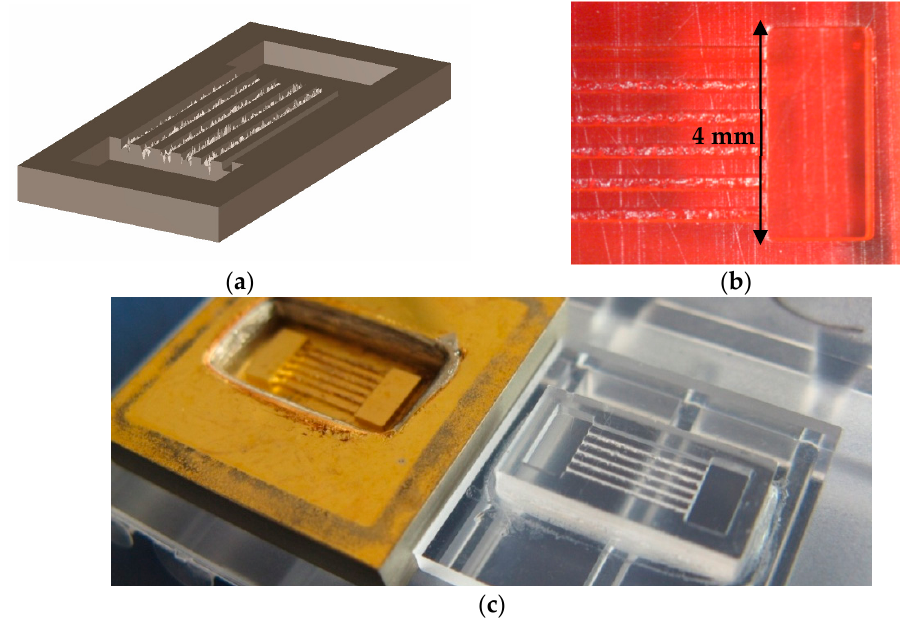
Figure 1. ( a ) Computer aided design of the multi-channel microsystem; ( b ) Master prototype obtained by additive manufacture (digital light projection or “DLP”); ( c ) Nickel mold insert and poly(methyl methacrylate) (PMMA) microsystem replica. Table 1. Influence of parameter “ α ” on channel fractal dimension and roughness.